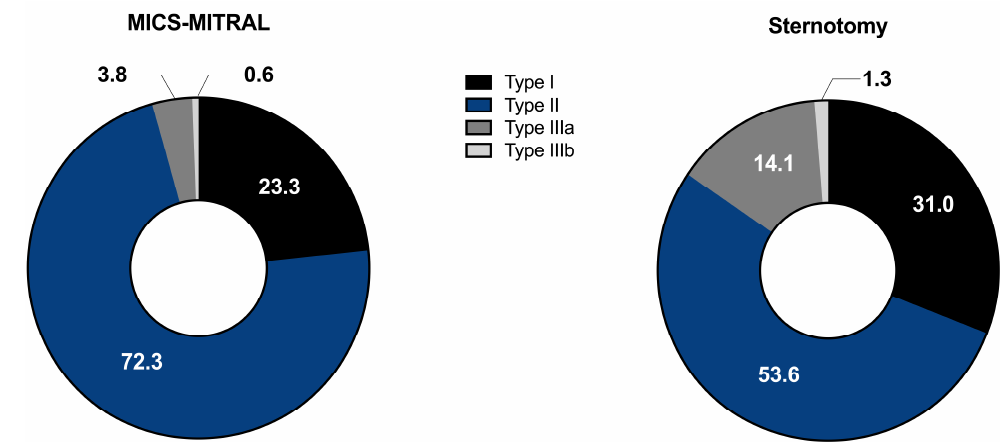
Figure 2. Intra-operative setup ( middle ) and the postoperative cosmetic result ( left / right ) of trans- axillary minimally invasive mitral valve surgery on postoperative day 2. illary minimally invasive mitral valve surgery on postoperative day